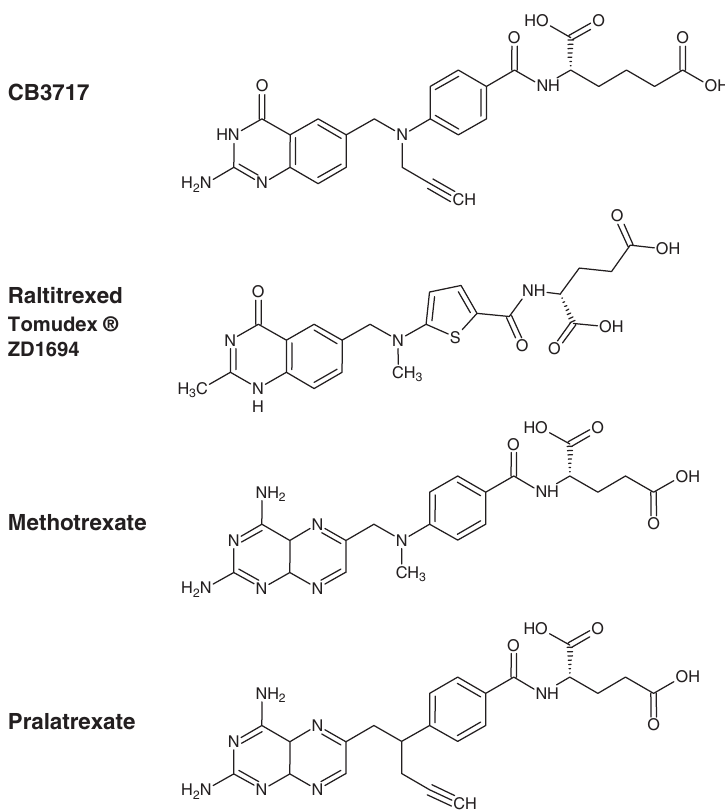
Figure 3: Chemical structures of THF and antifolate anticancer